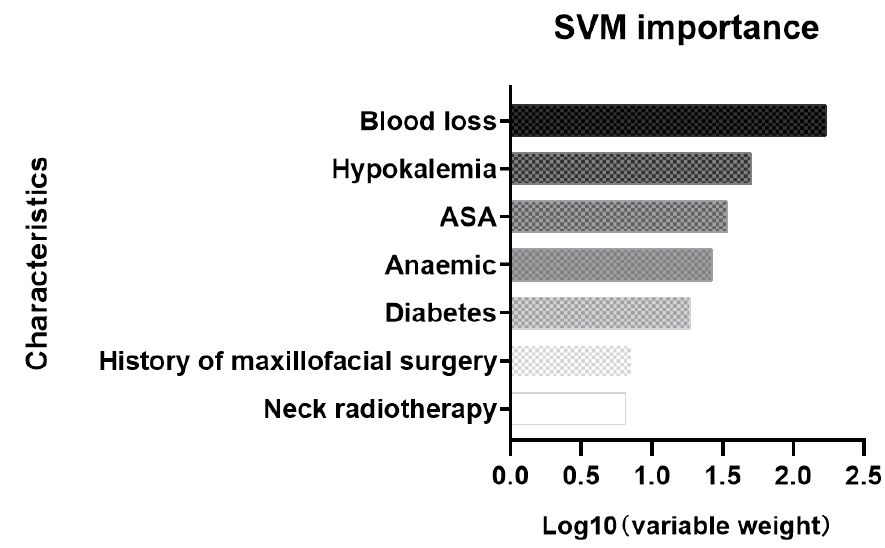
Figure 6. Assessment of the risk of extubation failure by logistic regression.